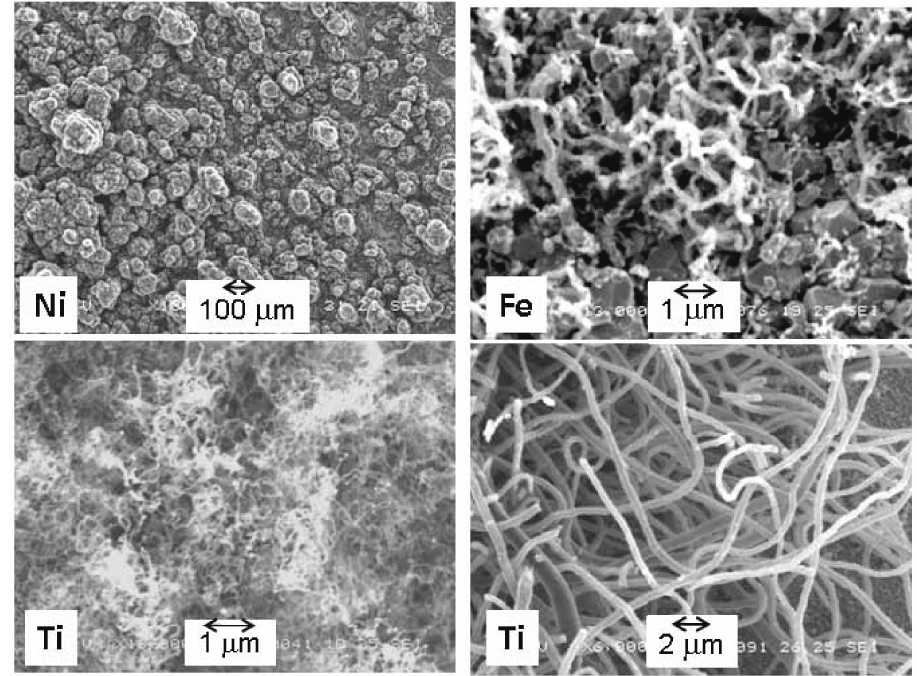
Figure 4. SEM images of the Ni, Fe, and Ti catalyst surface. The pyrolysis temperature is 973